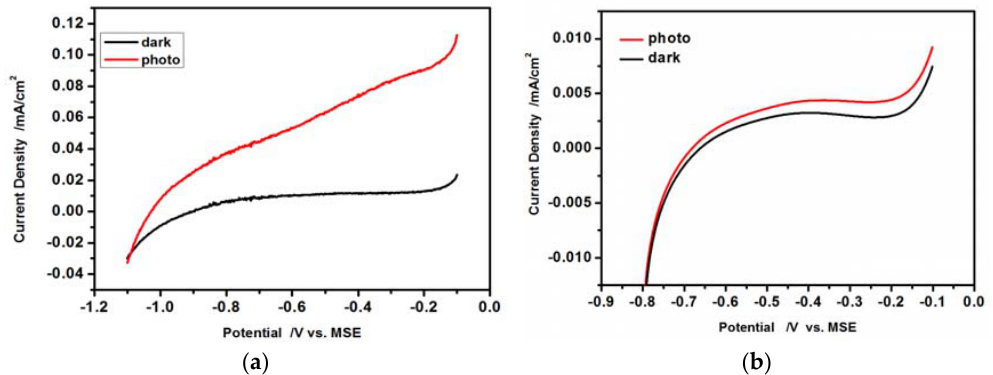
Figure 8. Linear scan curves recorded under dark and illumination vs. Mercurous Sulfate Electrode (MSE) electrode. Scan rate 20 mV/s; ( a ) CdS hydrophilic drop-cast nanoparticles on ITO; ( b ) 50 L-B layers of hydrophobic CdS nanoparticles deposited on ITO.